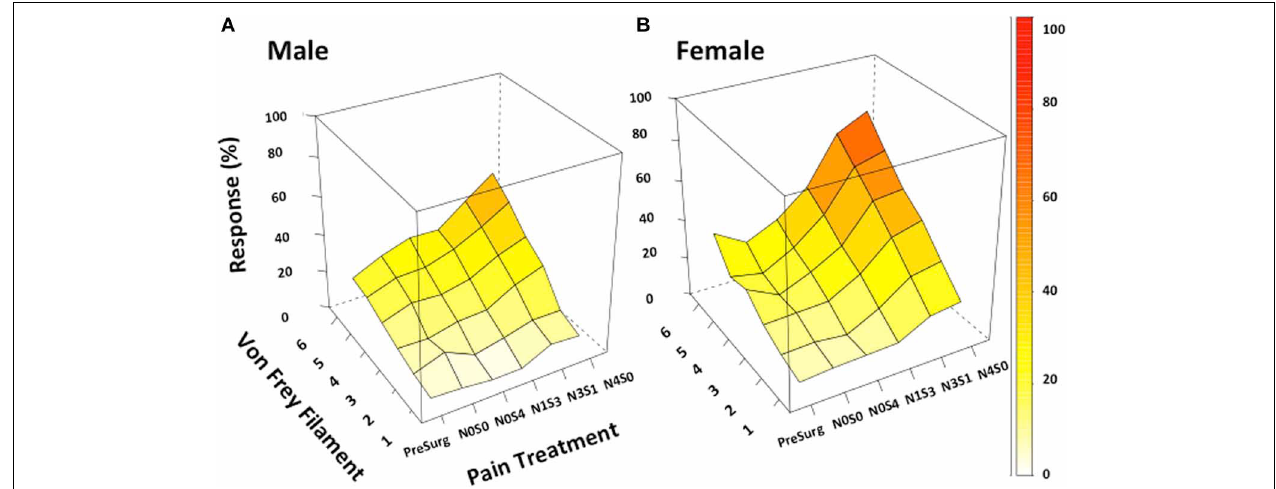
FIGURE 2 | von Frey test 3 demonstrates the ability to investigate chronic pain mechanisms without inflicting maximal pain. Appropriately investigating the role of sex in chronic pain became possible utilizing von Frey Test 3. Using this adapted behavioral test this study demonstrated the successful generation of a graded chronic pain model in both the male and female rat. Increasing the number of sciatic sutures was found to significantly increase the percentage response rate per von Frey filament in both males (A) and females (B) ( ≤ − 1.6%, t ≥ 4 . 9). Illustrating refinement of the traditional CCI procedure, females (N1S3, N3S1) were demonstrated statistically more allodynic than males